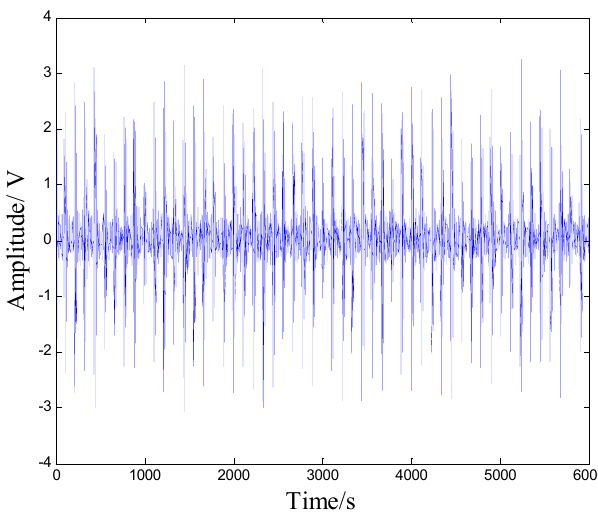
Figure 26. The time domain plot of outer race defect.